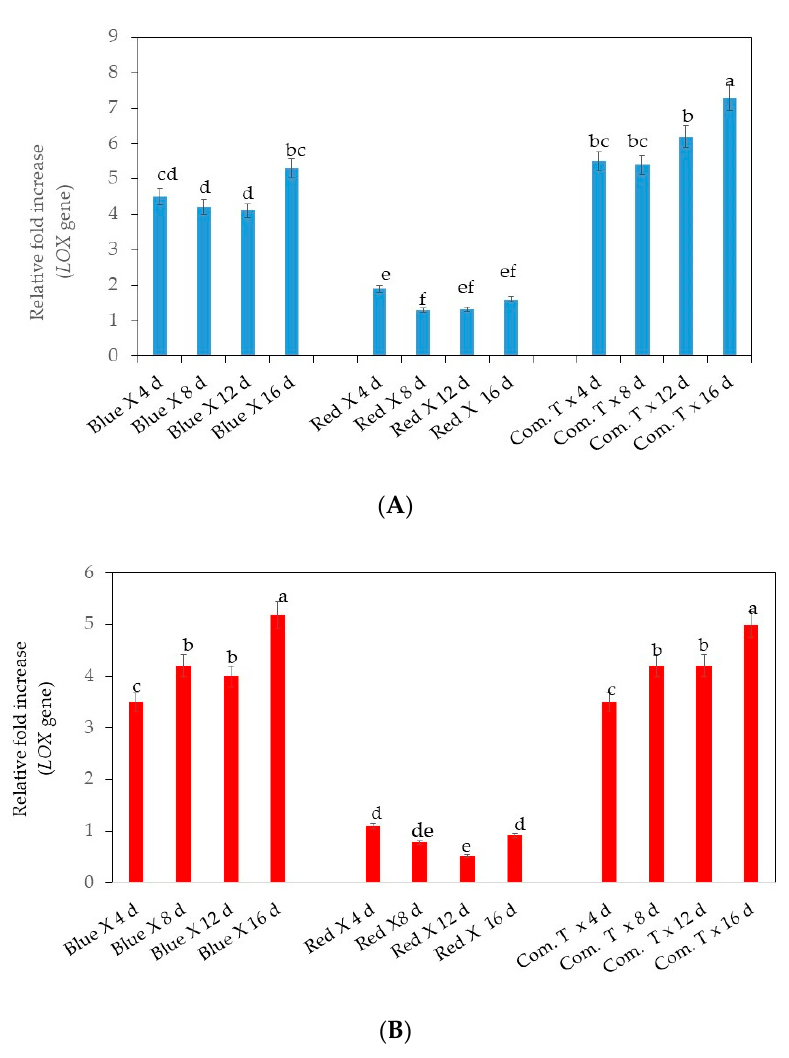
Figure 5. ( A ) . Influence of LED light exposure on LOX (lipoxygenase) gene expression in avocado cultivar Fuerte. ( B ) . Influence of LED light exposure on LOX (lipoxygenase) gene expression in avocado cultivar Hass. The exposure of fruit to blue or red LED light was for 6 h per day during storage. Number of replicates per treatment n = 5. Mean values of bars marked by different letters were significantly different at p < 0.05, according to Fisher’s protected LSD test. Blue, blue LED light; Red, red LED light; Com. T, commercial treatment.